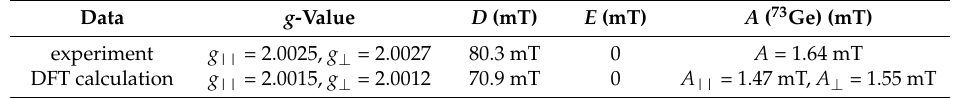
Table 6. Experimental and calculated g -, D -, and A -tensors for the GeV 0 ( S = 1) paramagnetic center [63].